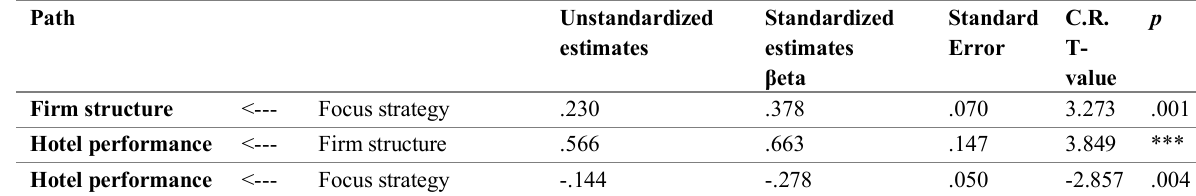
Table 2: Path Coefficients of Influence of Focus Strategy-Firm Structure Fit on Hotel